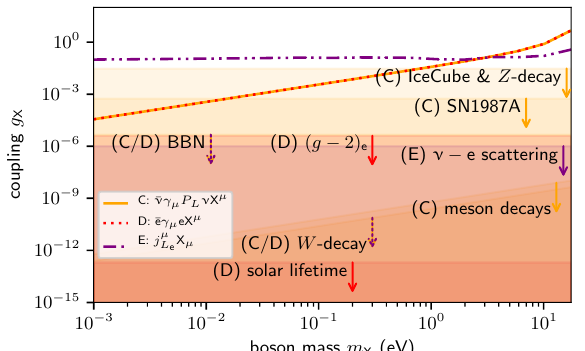
Figure 8 . Statistical sensitivity contours for eV-scale light vector bosons. Shown is the 90 % C.L. statistical sensitivity of Katrin for the detection of eV-scale light vector bosons. The types C, D, E are defined according to table 1 (C and D are indistinguishable for eV-scale vector bosons). Further- more, the shaded areas mark the parameter regions allowed from constraints discussed in section